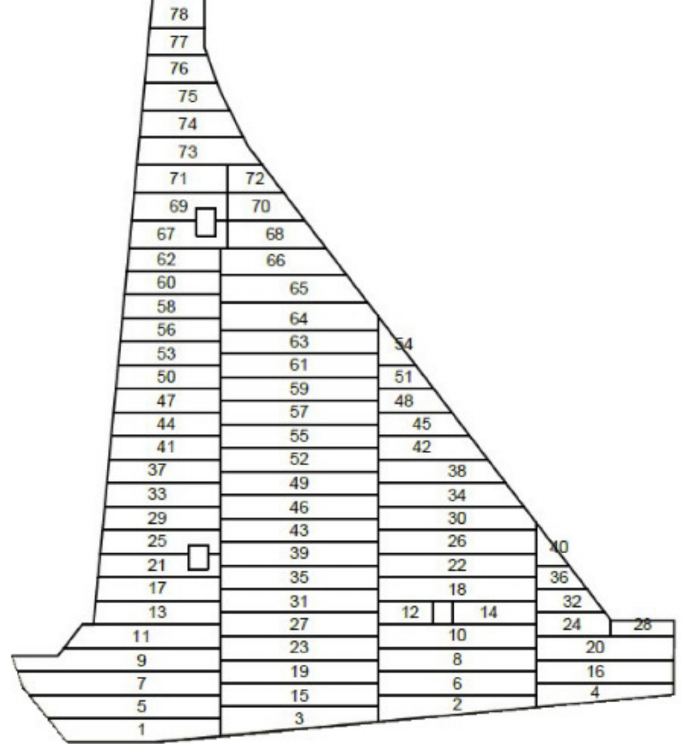
Figure 4. Concrete blocks in the gravity dam (numbers coincide with the sequence of